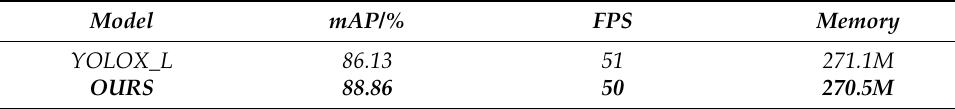
Table 2. Effectiveness of our method on YOLO_L.